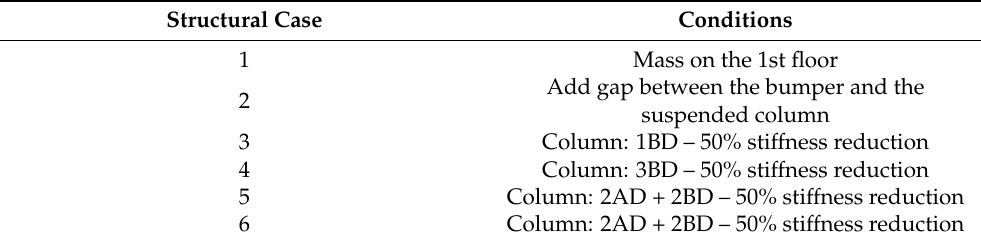
Figure 7. Benchmark Structure 2: the three-story frame structure. Table 2. Dataset 2: description of structural benchmark